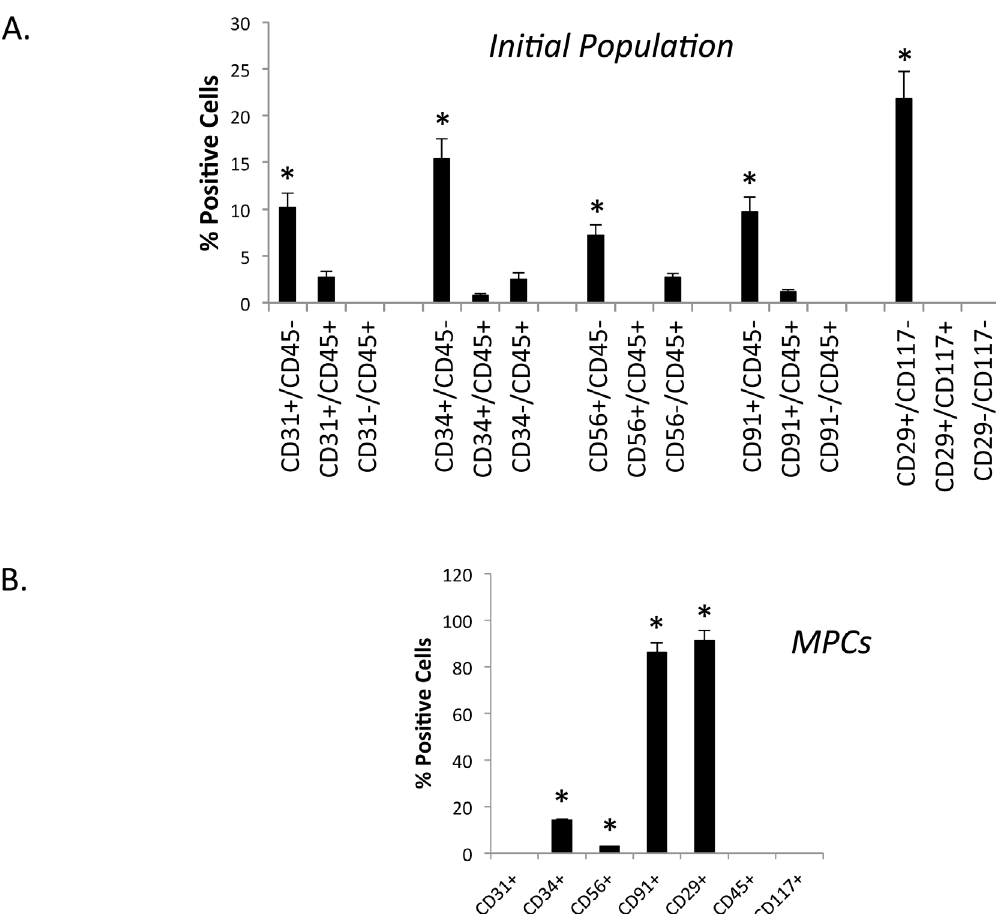
Fig. 4. Flow cytometry analysis of a single cell suspension from traumatized muscle. A. A single cell suspension from collagenase digested muscle tissue (Figure 1C) analyzed directly by flow cytometry using fluorescent-conjugated antibodies against the cell surface markers indicated in the figure. The bar graph indicates the number of positive cells for each marker (mean ¡ SEM, n 5 6). Significant difference is observed (*) between the first sub-population compared to the next two sub-populations for all five sets (Mann Whitney U test, p # 0.01). B. Cells isolated after two hours adherence, (Figure 1B) were analyzed by flow cytometry using the indicated antibodies. The bar graph indicates the number of positive cells for each marker (mean ¡ SEM, n 5 8). Significant difference is observed (*) between CD34, CD56, CD91, CD29 and CD31, CD45 and CD117 (Mann Whitney U test, p # 0.01).